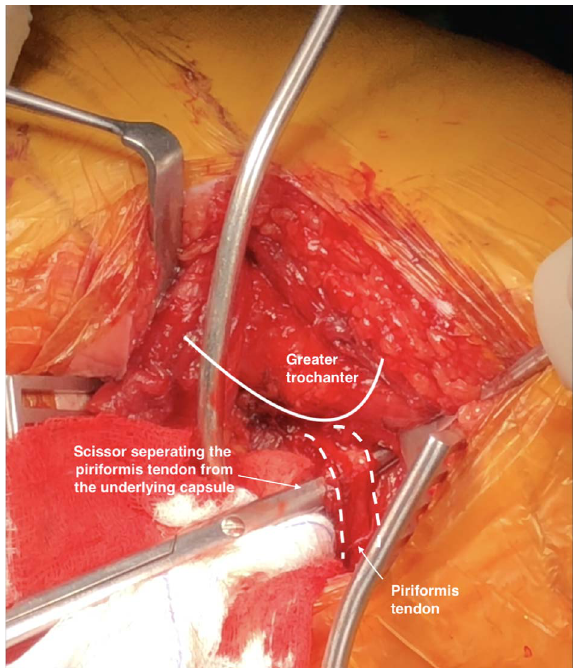
Figure 2. The fi gure depicts the separation of the piriformis tendon from the underlying capsule using a